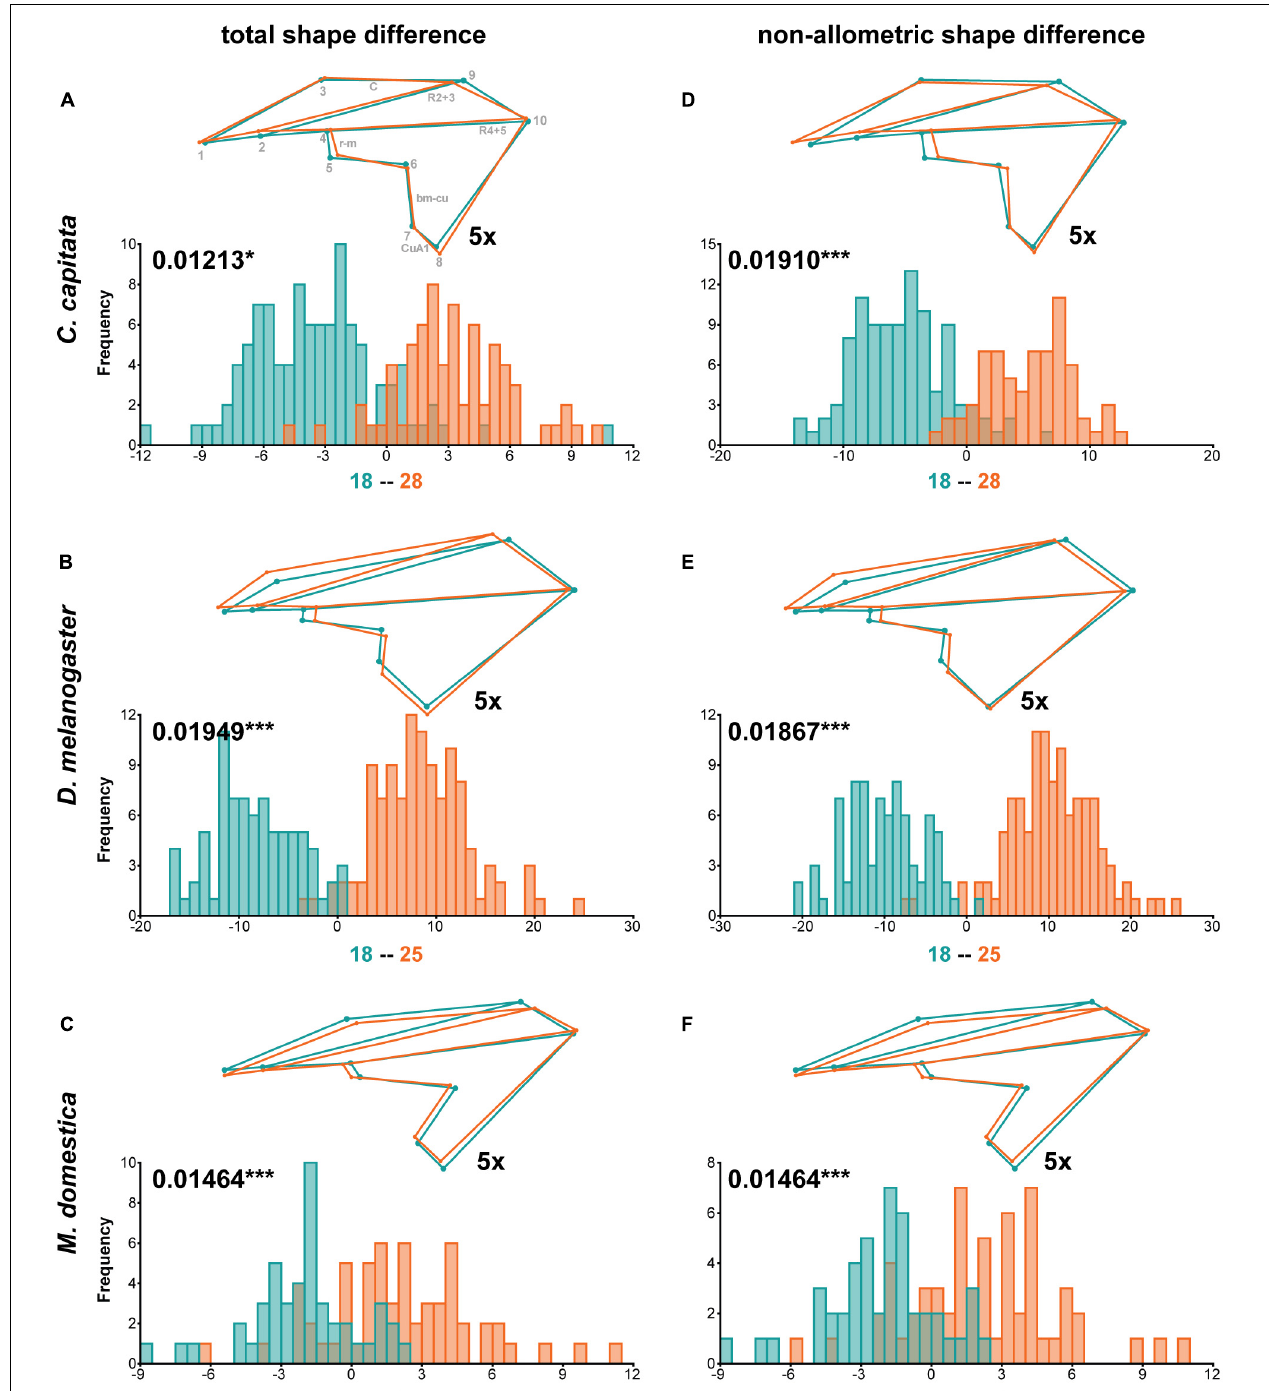
FIGURE 4 | Total and non-allometric shape differences due to different rearing temperatures. Summary of discriminant function analyses for total (A–C) and non-allometric (D–F) shape differences for flies raised at different temperatures. The wireframes represent differences between the low temperature (turquoise) and high temperature (orange) average wing shapes. The scale factor is provided next to the wireframes. The magnitude of shape variation is indicated in units of Procrustes distance with the corresponding p -values based on 1,000 random permutations (* P ≤ 0.05 and *** P ≤ 0.001). Histograms with the distributions of the discriminant scores show shape separation into two distinct groups for each species. See also Supplementary Table 5 for details.